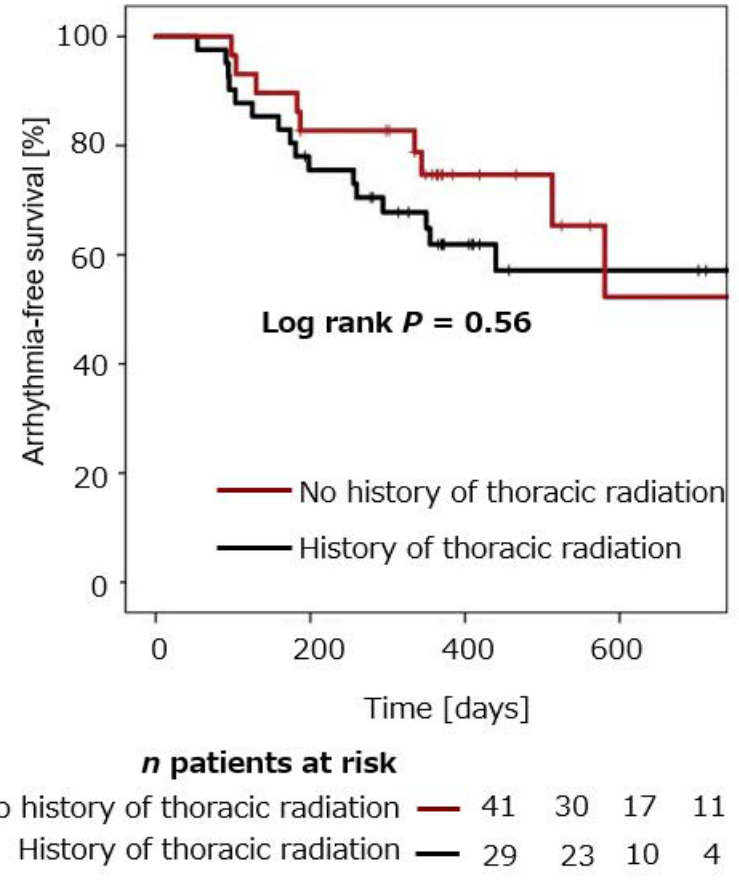
Figure 2. Cumulative freedom from arrhythmia recurrence after CB-PVI in cancer patients with thoracic radiation compared to cancer patients without thoracic